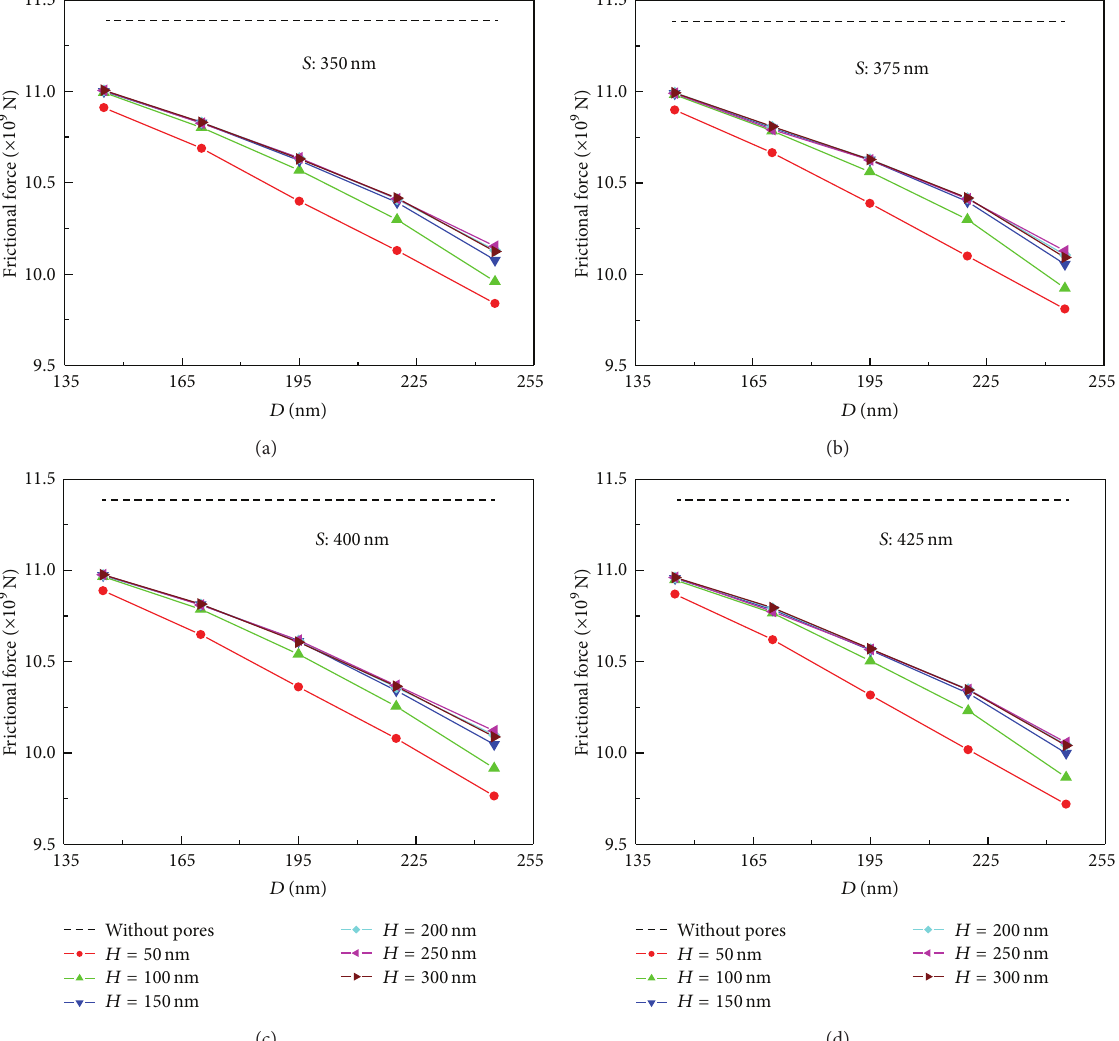
Figure 5: Frictional forces at different pore diameters and depths of Coscinodiscus sp.: (a) at interval of 350 nm, (b) at interval of 375 nm, (c) at interval of 400 nm, and (d) at interval of 425